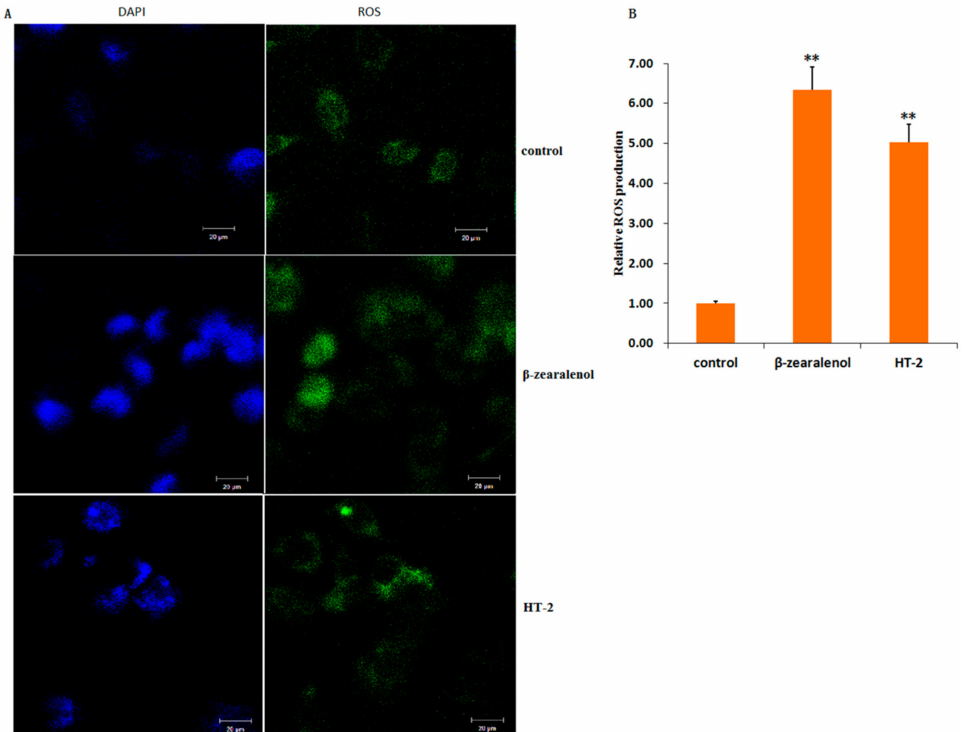
Figure 7. β -zearalenol or HT-2 treated intracellular reactive oxygen species (ROS) accumulation in bovine granulosa cells. ( A ) Fluorescent photomicrographs of GCs stained with 2 (cid:48) ,7 (cid:48) -dichlorofluorescin diacetate (H2DCFDA) are shown for control, β -zearalenol / HT-2 over the time course of 24 h. The images shown are representative of the three independent image acquisitions. ( B ) Quantitative analysis of relative fluorescence emission. Values are expressed as the mean ± S.D. of n = 3. ** p < 0.01 versus the control group; CON, control group; β -zol, β -zearalenol treatment; HT-2, HT-2